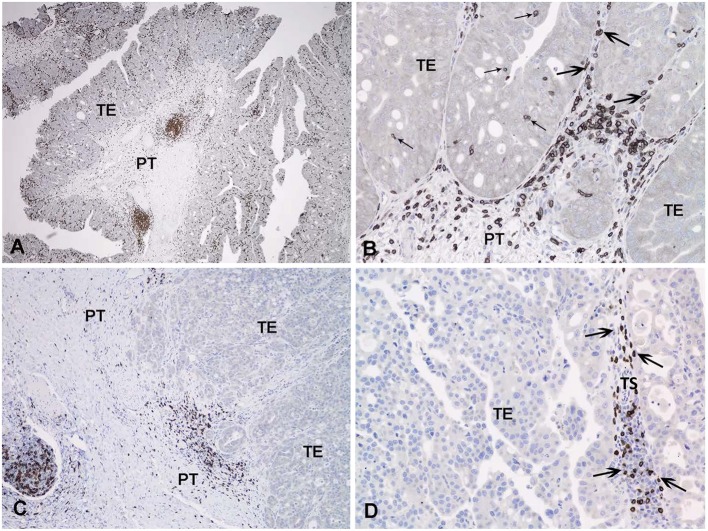
Immunohistochemical detection of T lymphocytes with an antibody to CD3 in canine invasive urothelial carcinoma. In (A) all areas examined (intraepithelial, tumor stroma, and peritumoral) contain CD3 positive cells. In (B) a detail of the triphasic pattern of CD3 expression is noted. In (C) only the peritumoral lymphoid infiltrate expresses CD3 in this tumor. In (D) the tumoral stroma contains numerous CD3 positive lymphocytes, but the tumor epithelium is negative. TE, tumoral epithelium; TS, tumoral stroma; PT, peritumoral stroma; Small arrow, intraepithelial T-lymphocytes; Large arrow, tumoral stroma T lymphocytes.